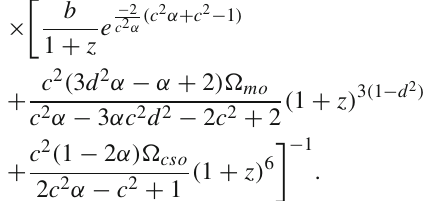
Fig. 3 Plot of EoS parameter ω 1 ,ω 2 and ω 3 against redshift z (cid:3) ×